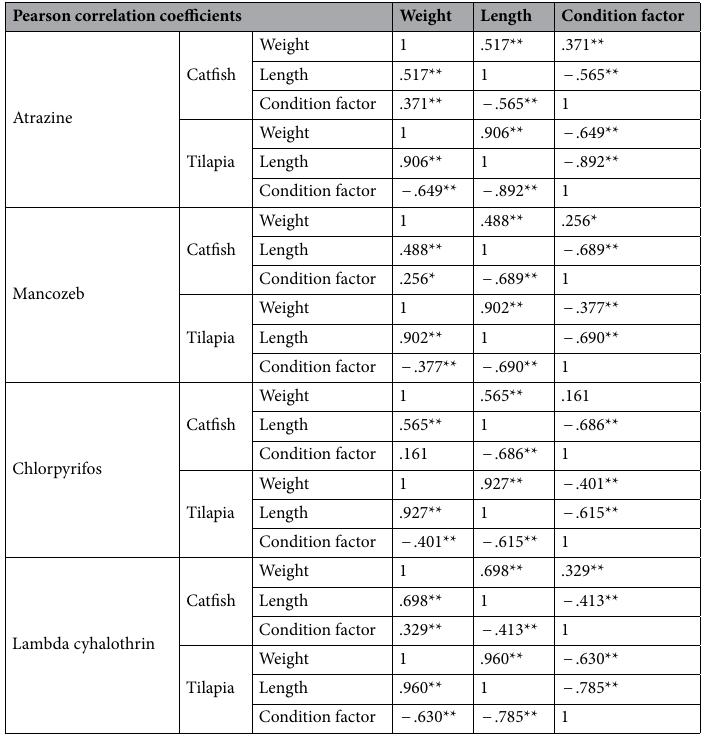
Table 2. Correlation between covariates. *Correlation is significant at the 0.05 level (2-tailed). **Correlation is significant at the 0.01 level